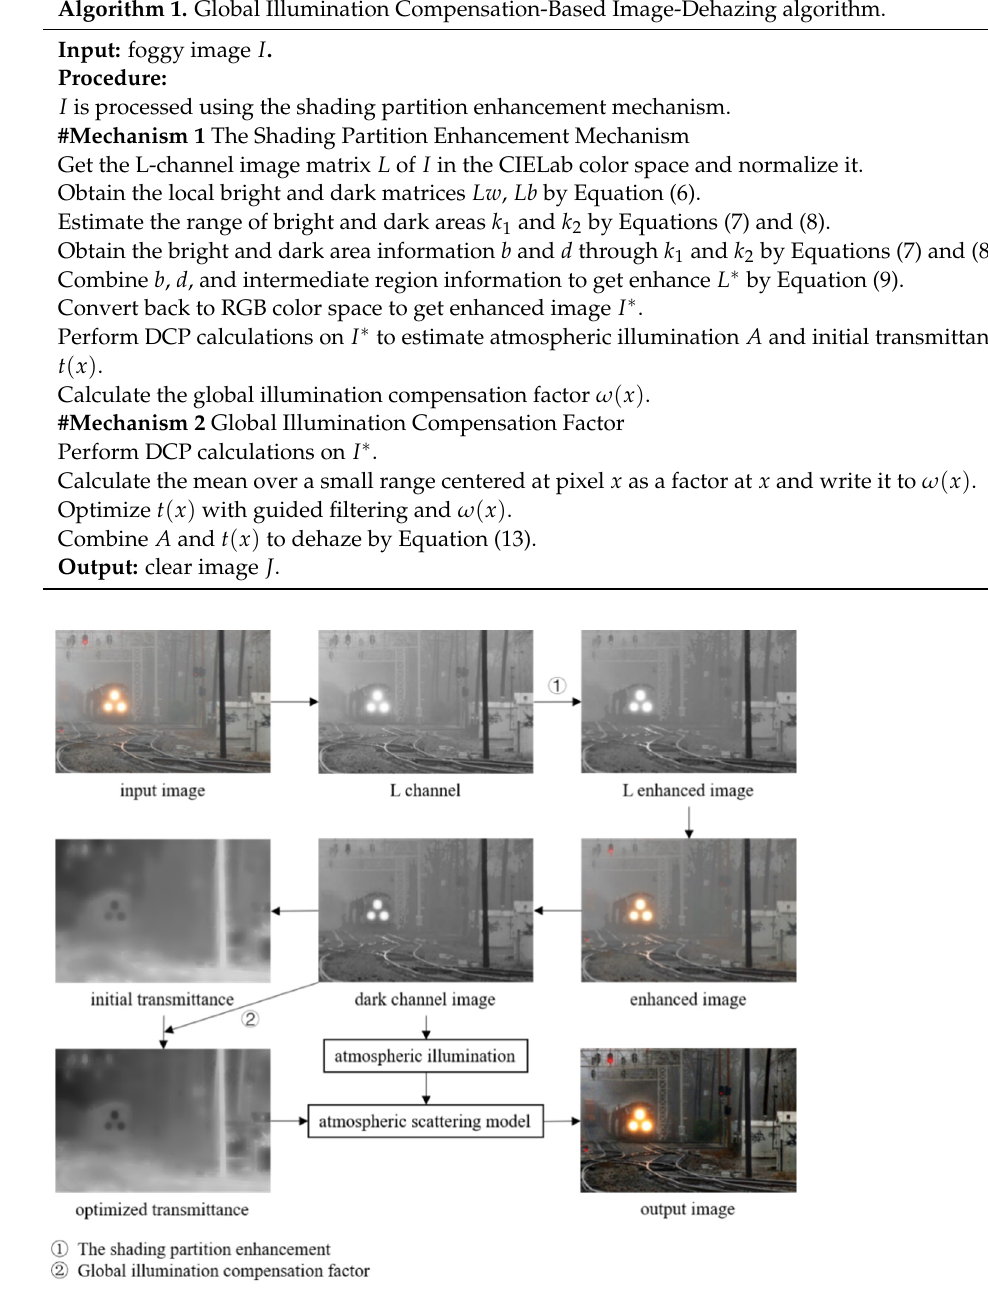
Figure 2. The flow chart of the proposed GIC algorithm. Steps 1 and 2, denoted as the shading